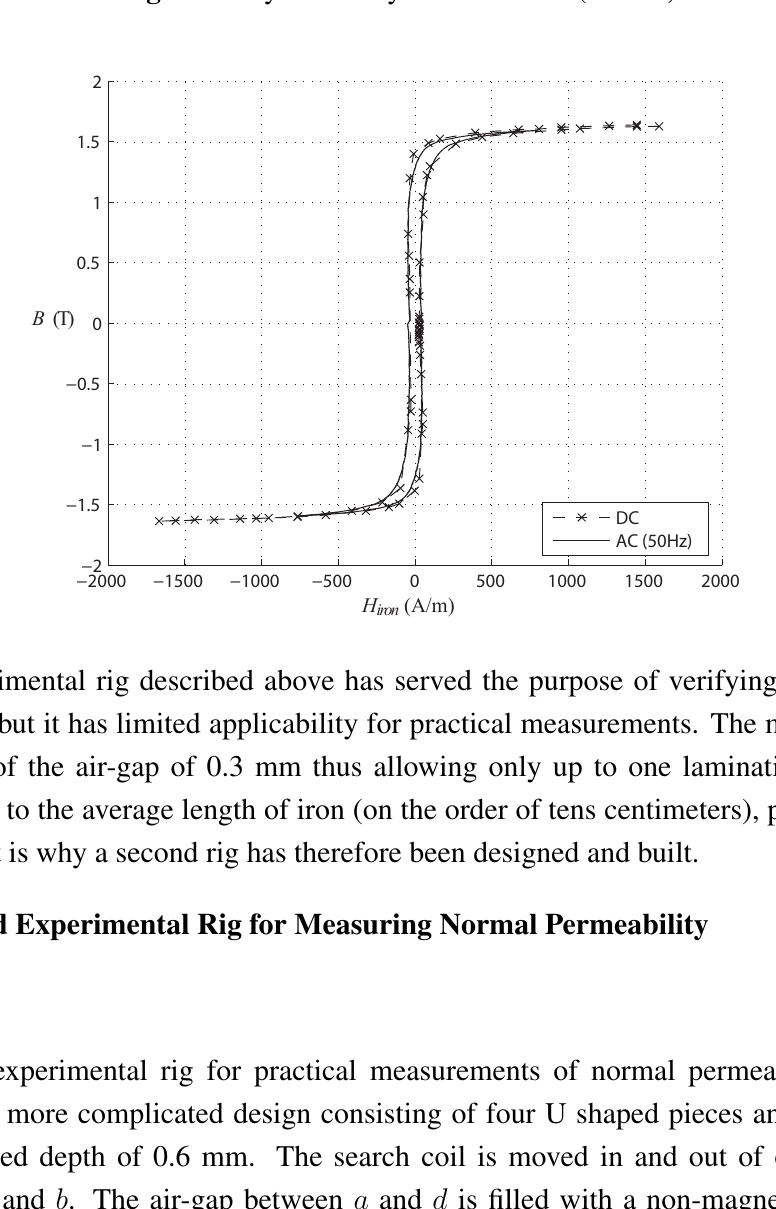
Figure 4. Hysteresis cycle of the iron (U